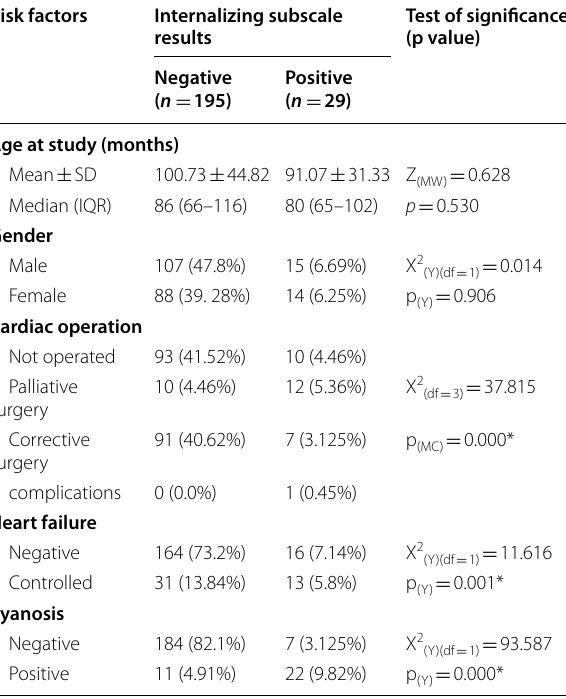
Table 3 Comparison between patients with negative and positive results for the total internalizing subscale of PSC